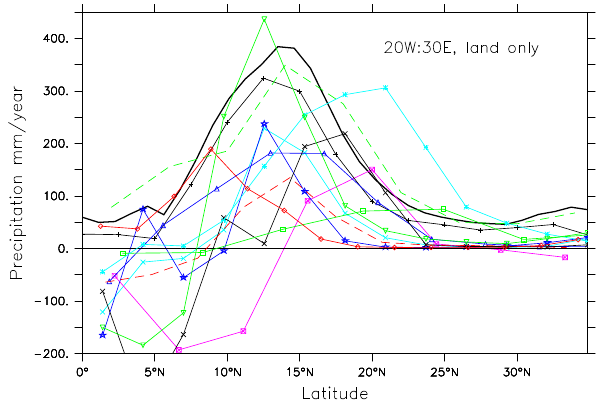
Fig. 15. Annual mean precipitation difference MH-PI over North Africa (20 ◦ W:30 ◦ E, land only). The thick black line is for EC-Earth, coloured lines are for PMIP2 ocean-atmosphere models. The colours and symbols are the same as in Braconnot et al. (2007a), Fig. 10. See their Table 2 for model characteristics and references. Two additional models that are included here are: GISS modelE (green dashes, Schmidt et al., 2006) and CSIRO (red dashes, Gor- don et al.,